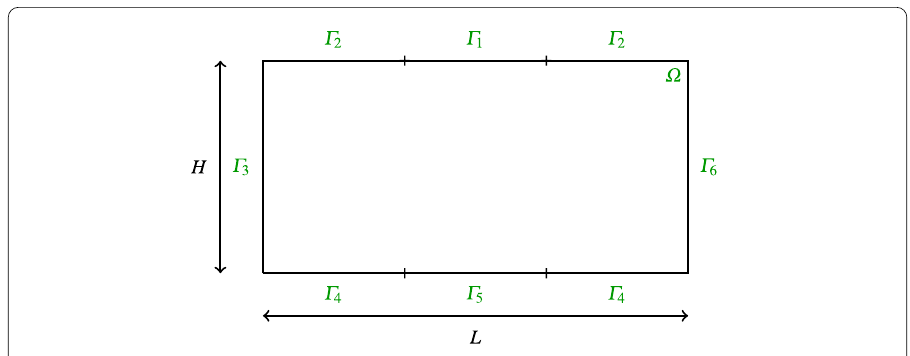
Figure 10 Sketch of the setup for the two-dimensional squeeze